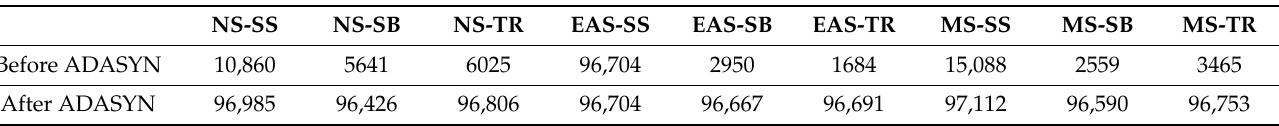
Table 5. The size of training splits before and after applying ADASYN for balancing the training split of the data for classification